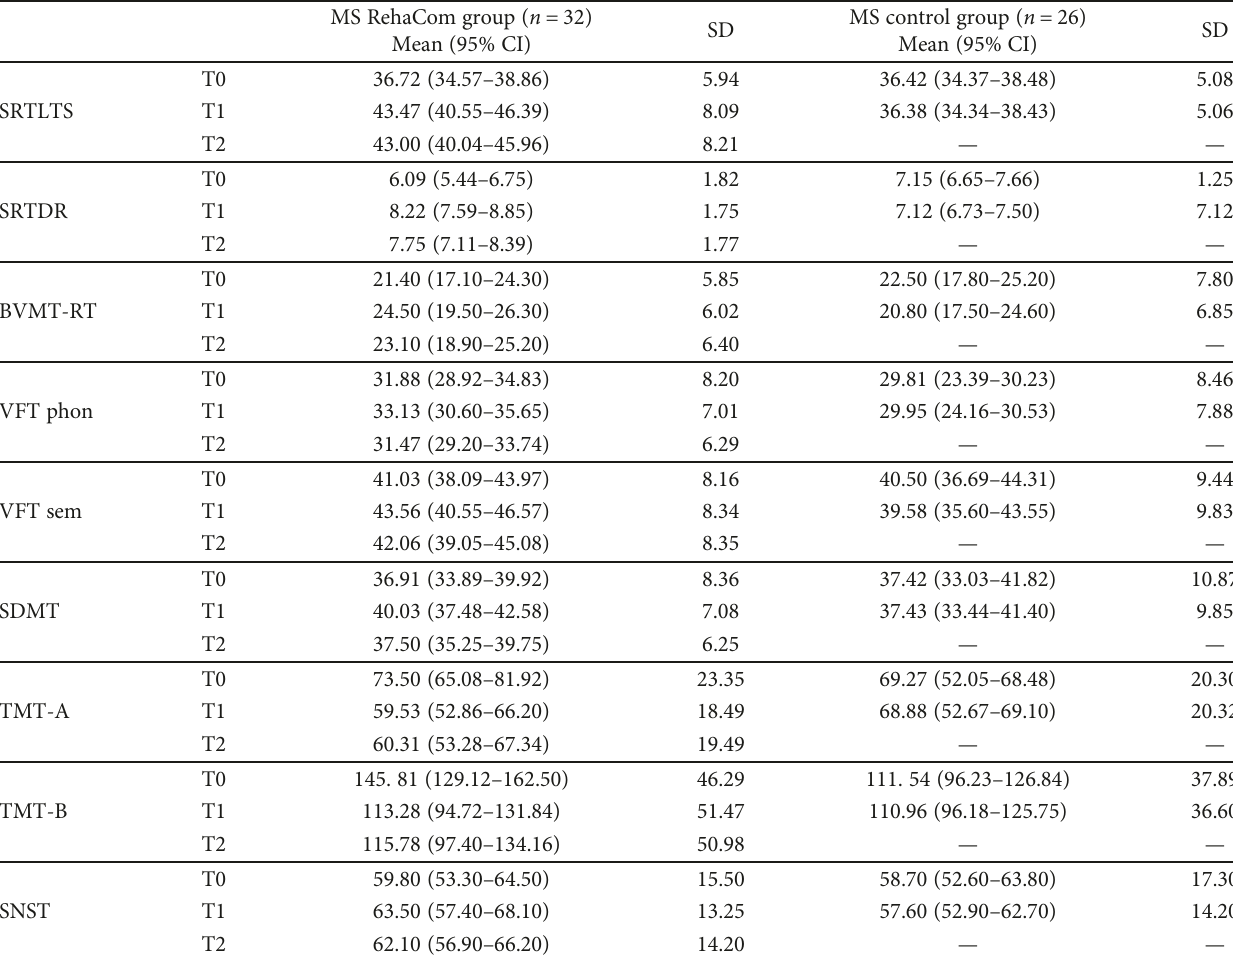
Table 3: Performance on neuropsychological measures for the RehaCom and control group at baseline, posttreatment, and at 6-month